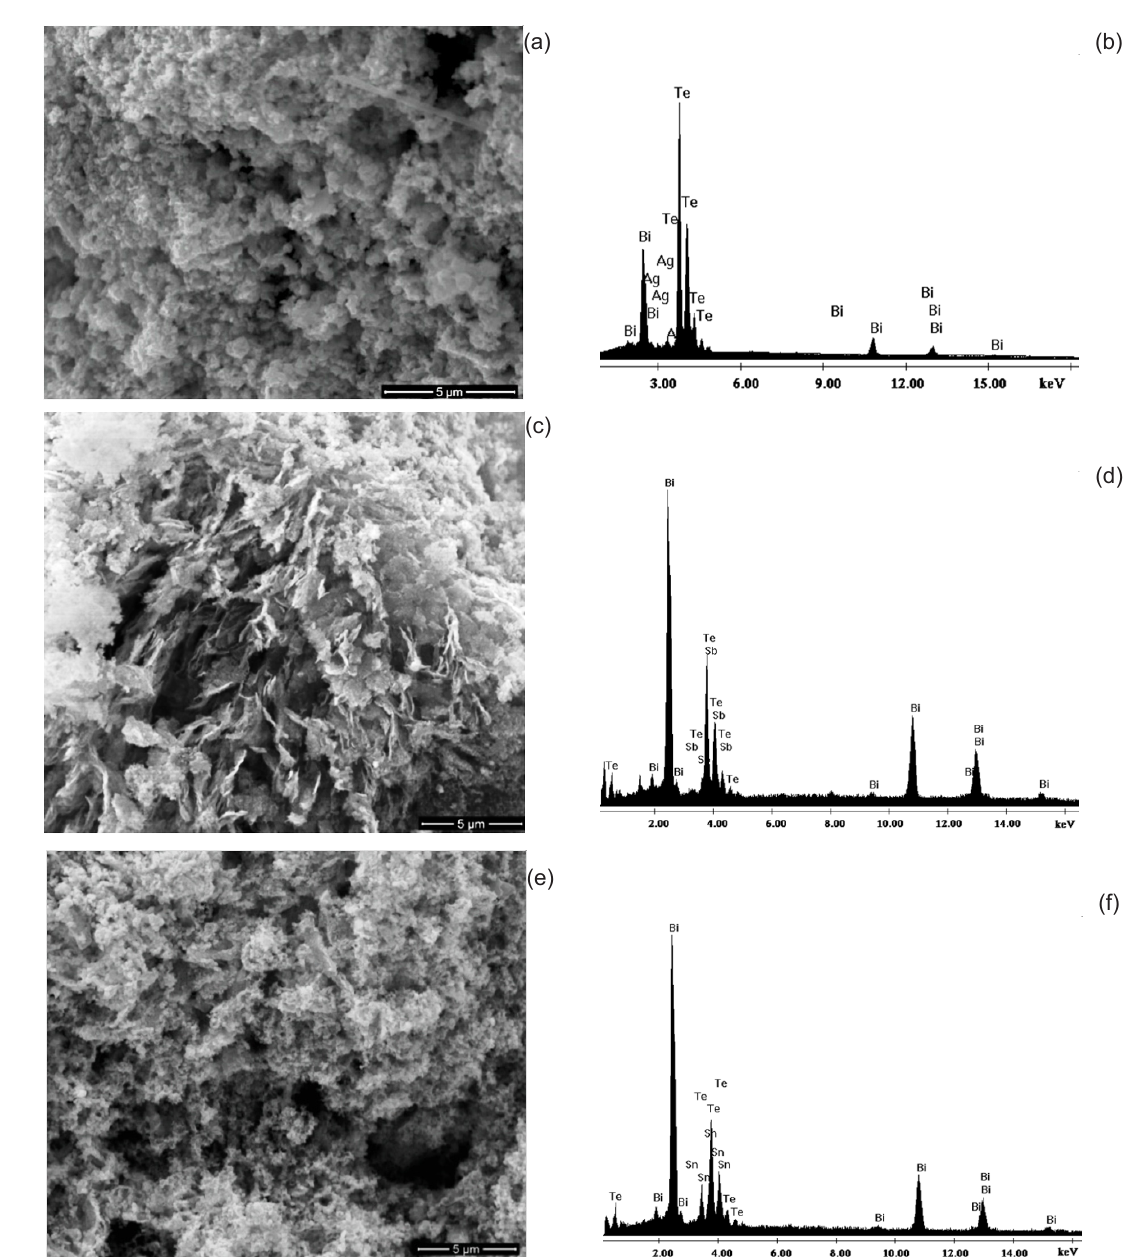
Figure 2. SEM morphology for: S1 (a), S2 (c), and S3 (e) and EDX elemental analysis for: S1 (b), S2 (d), and S3 (f), synthesized by ultrasonically assisted hydrothermal